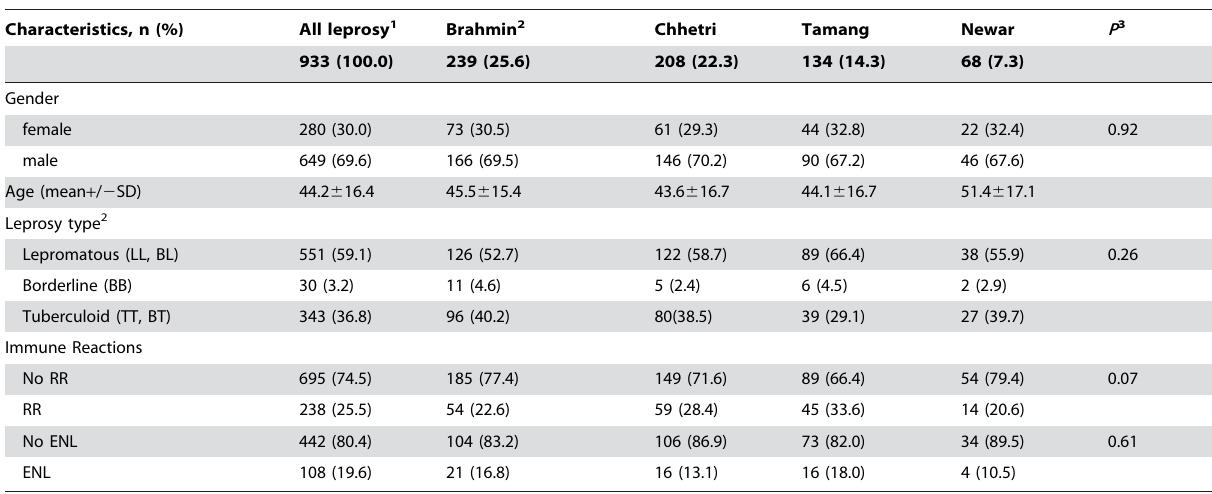
Table 1. Baseline characteristics of leprosy subjects.